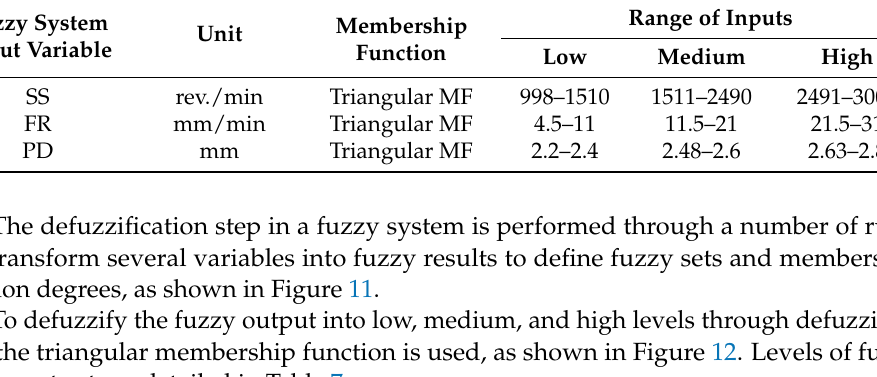
Figure 9. Fuzzification of FSSW strength fuzzy system inputs. Table 6. Membership functions of FSSW strength fuzzy system